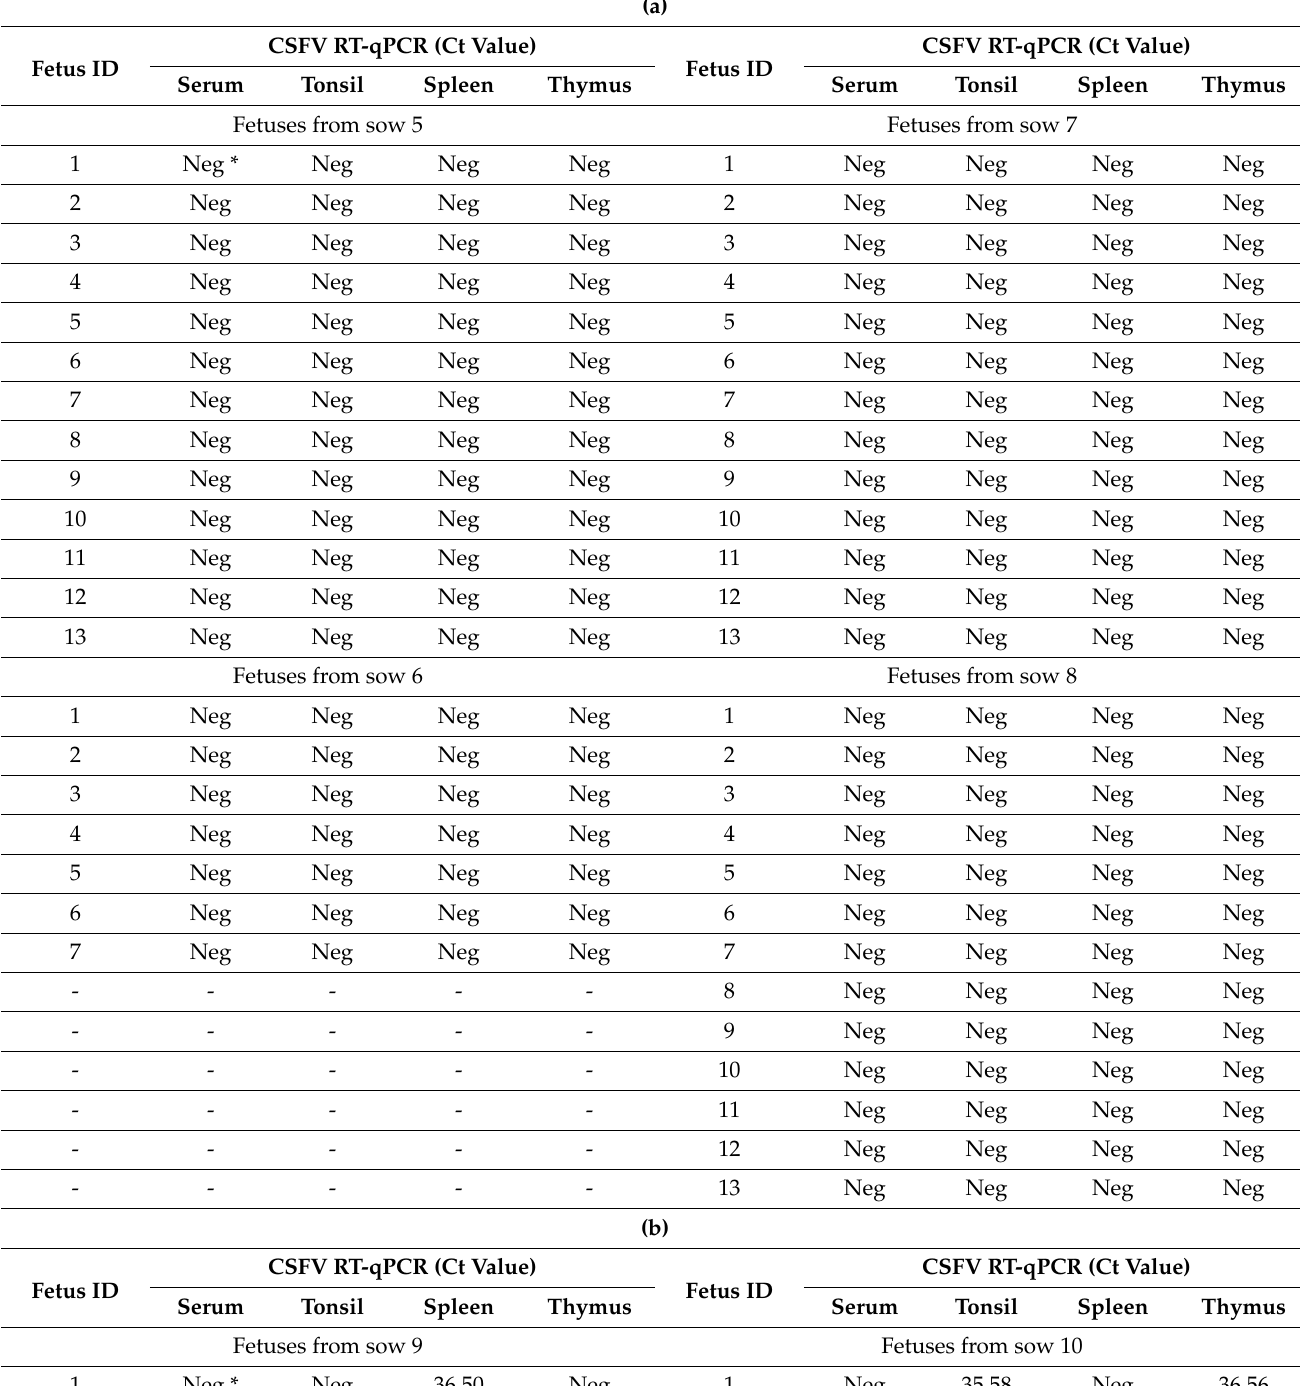
Table 2. Detection of CSFV RNA in tissue samples of fetuses from either vaccinated or non-vaccinated sows after challenge: ( a ) Tissue samples of fetuses from vaccinated sows, ( b ) Tissue samples of fetuses from non-vaccinated